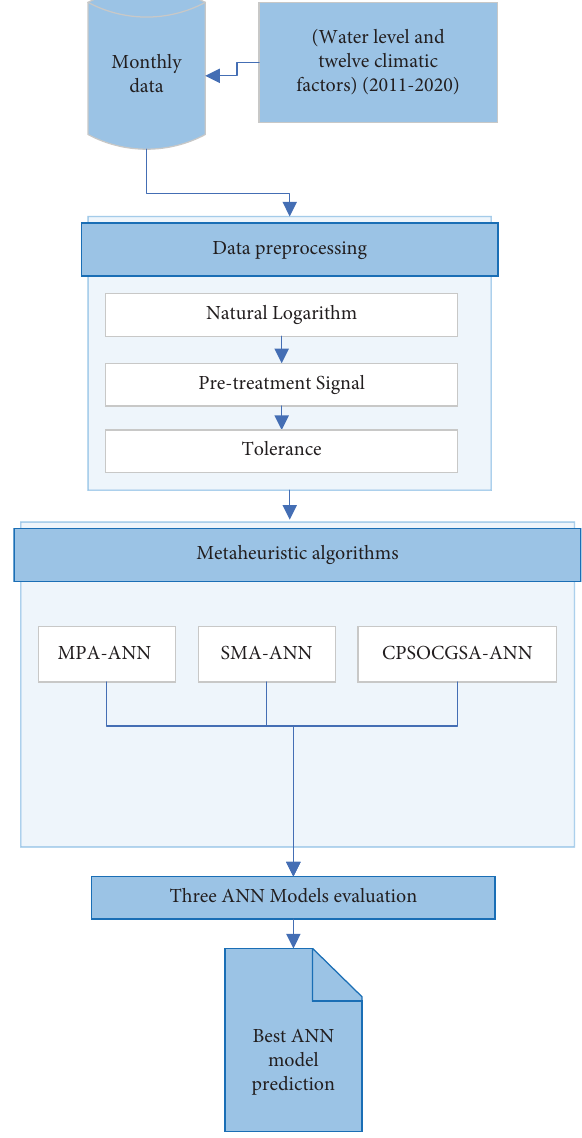
Figure 3: The suggested methodology for predicting water